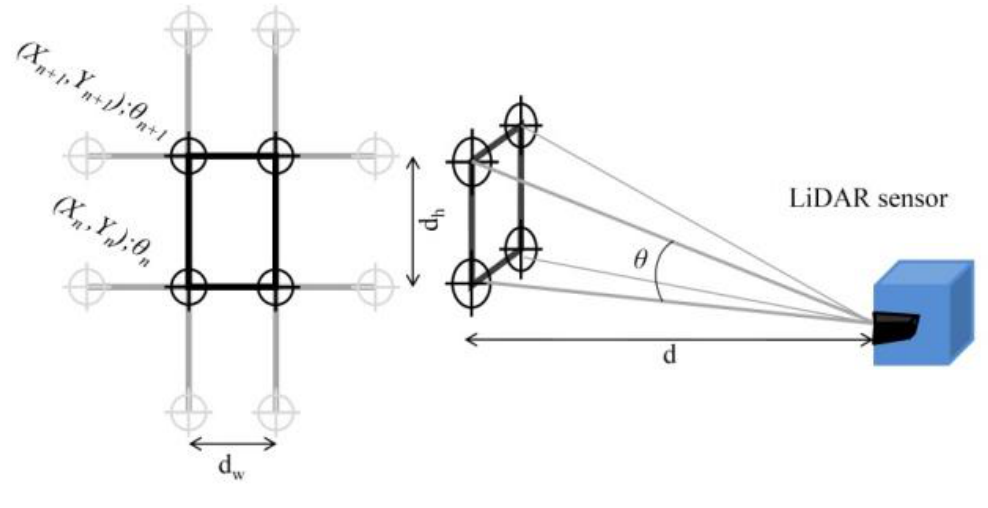
Figure 1. Definition of the reference grid for LiDAR